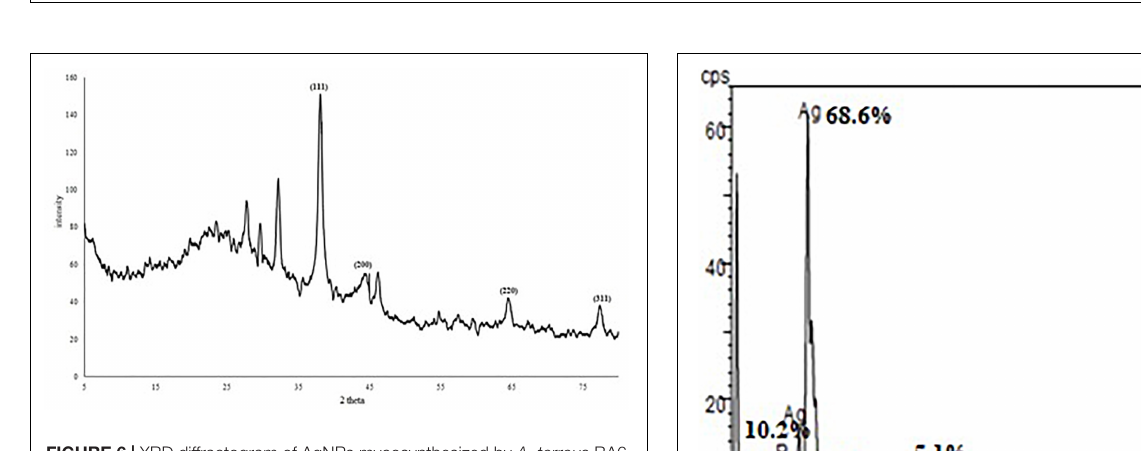
FIGURE 6 | XRD diffractogram of AgNPs mycosynthesized by A. terreus BA6.